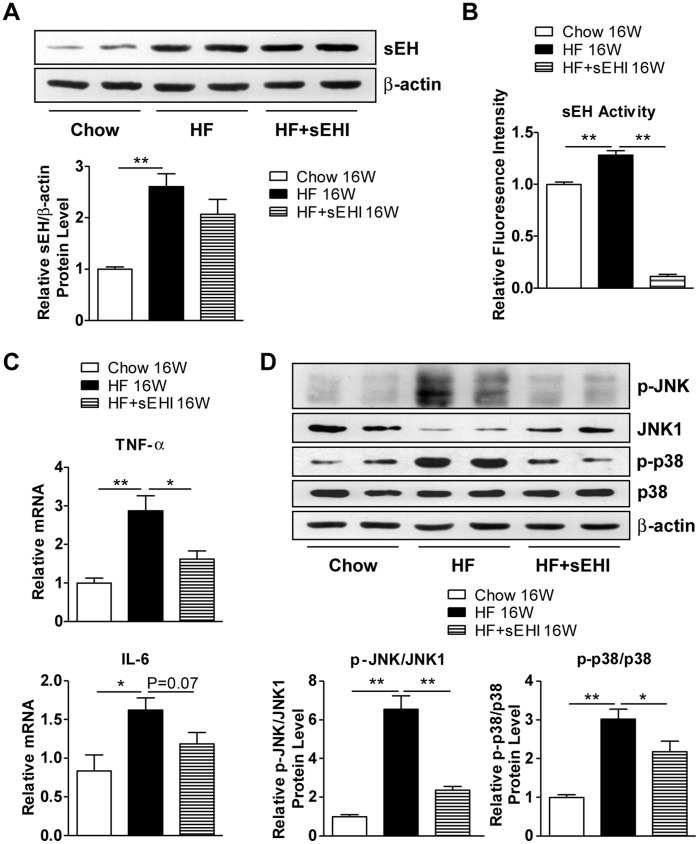
sEH inhibition decreased 16-week HF-diet–induced activation of inflammatory pathways in the liver.Male C57BL/6 mice were fed a regular chow or HF diet for 16 weeks with or without sEHI t-AUCB in drinking water starting 3 days before diet. (A) Western blot analysis of protein levels of sEH and β-actin as a normalization control in liver. (B) sEH activity in liver. (C) Quantitative RT-PCR analysis of mRNA levels of TNF-α and IL-6 in liver. (D) Western blot analysis of protein levels of phosphorylated Jun N-terminal kinase (p-JNK), JNK1, p-p38, p38 and β-actin and relative protein content compared to that of JNK1 or p38. Data are mean ± SEM. (* P<0.05, ** P<0.01).